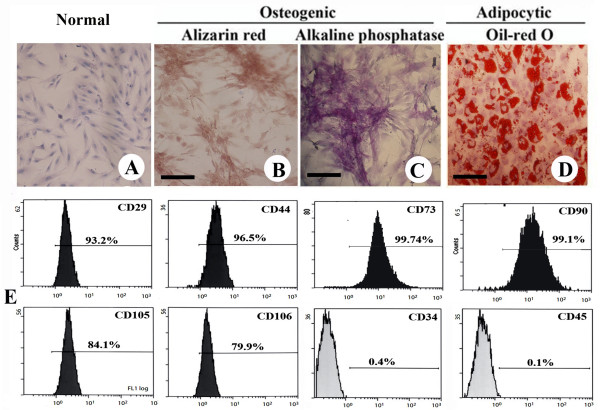
UC-derived MSC-like cells in passaged cultures. (A) H&E staining of UC-derived MSC-like cells. Osteogenic differentiation as indicated by (B) the formation of mineralized matrix shown by alizarin red staining and (C) alkaline phosphatase expression. Adipocytic differentiation was noted by the presence of broadened morphology and formation of lipid vacuoles (D) (positive oil-red O staining). Scale bars = 80 μm. (E) Immunophenotype of UC-derived MSC-like cells.